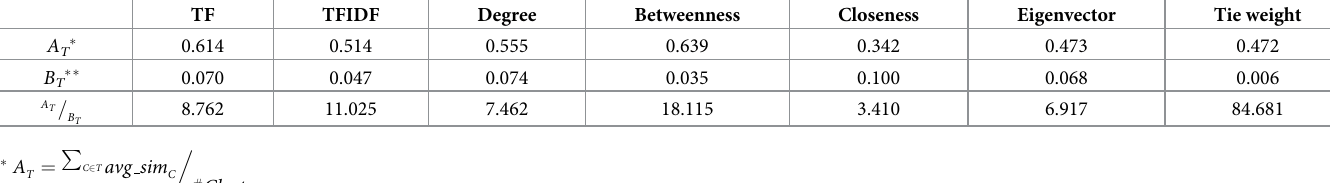
Table 5. A T of each vector B T